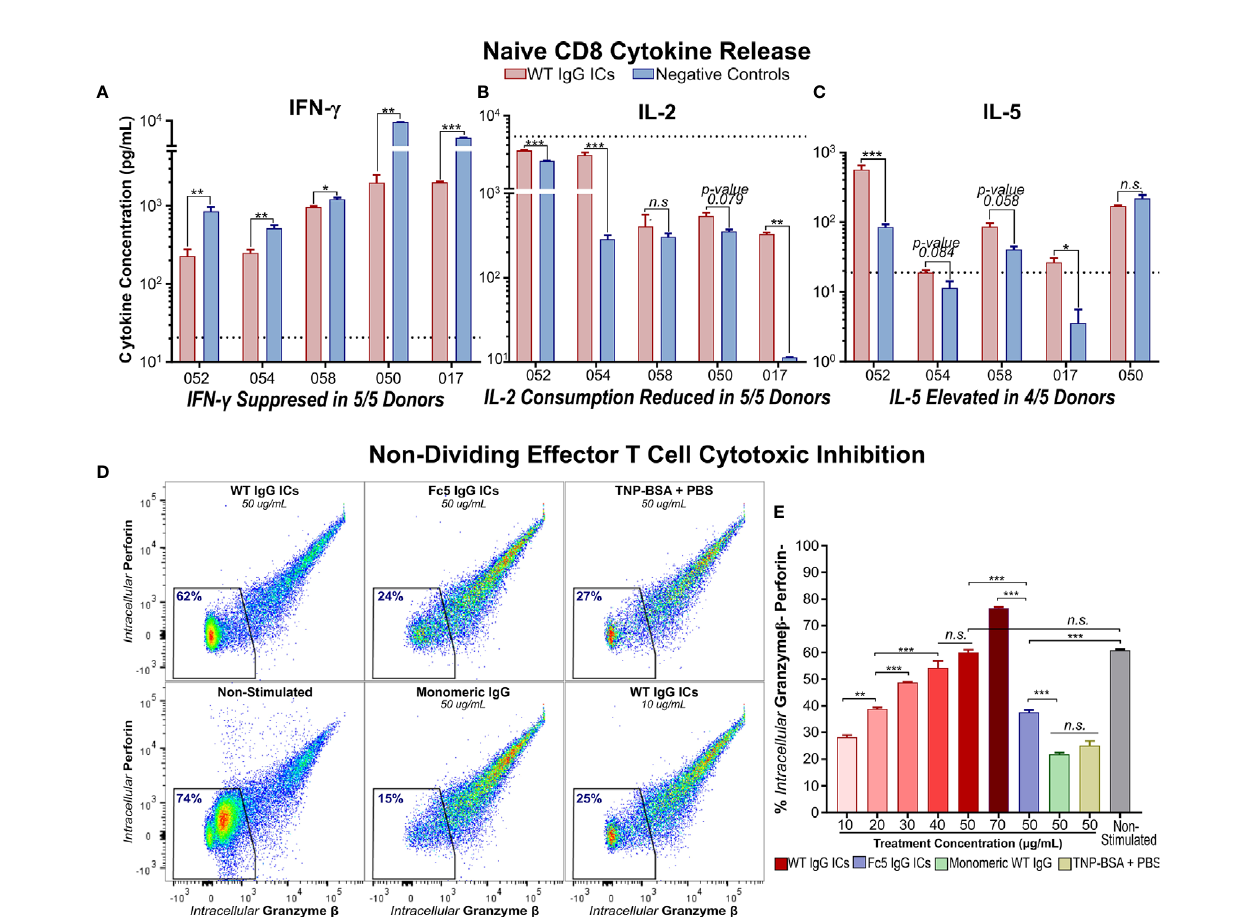
FIGURE 3 | IgG Immune Complexes Suppress IFN- g Secretion by Activated Naïve CD8+ T cells and Inhibit Effector Molecule Production by Cytotoxic Memory T Cells (A – C) IFN- g , IL-2, and IL-5 secretion by activated naïve CD8+ T cells incubated with (WT) IgG1-ICs or controls (Fc5 IgG1-ICs, monomeric IgG1, or PBS). Dashed line represents the average cytokine concentration in non-activated cultures from two donors (D) Flow cytometry analysis of intracellular production of perforin (Prf) and granzyme- b (Gzm b ) in non-proliferating effector memory T cells. Puri fi ed CCR7- T cells were either (i) unstimulated and untreated or (ii) activated and incubated with IgG1-ICs or indicated controls. The percent of Gzm b (-) Prf(-) cells is indicated in blue. (E) Gzm b /Prf production as a function of IgG1-IC concentration or 50 m g/mL negative controls. The assay was run in triplicate wells. (A – E) Error bars represent the standard error of the mean (SEM). Asterisks *, **, and *** indicate p-values < 0.05, p-values < 0.01, and p-values < 0.0001 respectively. “ n.s. ” stands for statistically not signi fi